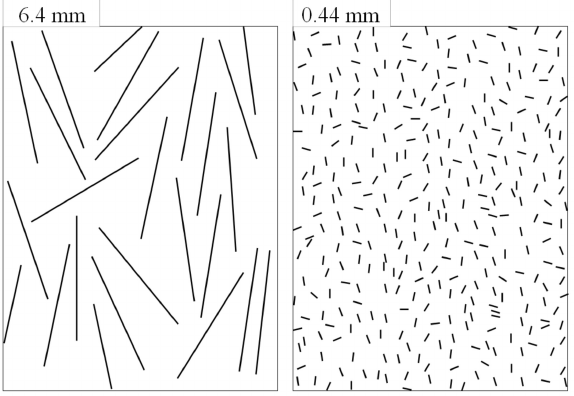
Figure 10. Schematic of increase in spaces between fibers, S f , showing closer fiber proximity. Total fiber length is illustrated as equal to represent a constant V f